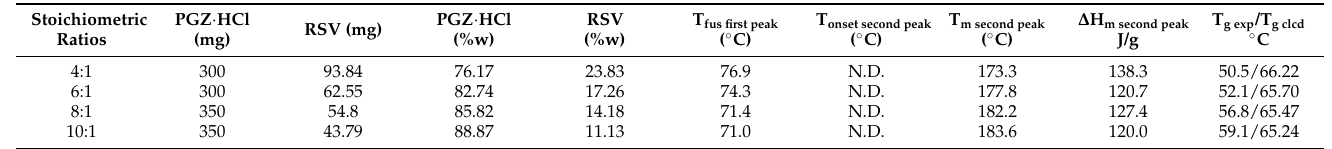
Table 5. Thermodynamic data of the different solid forms of PGZ · HCl-RSV at different stoichiometric ratios (4:1, 6:1, 8:1, and